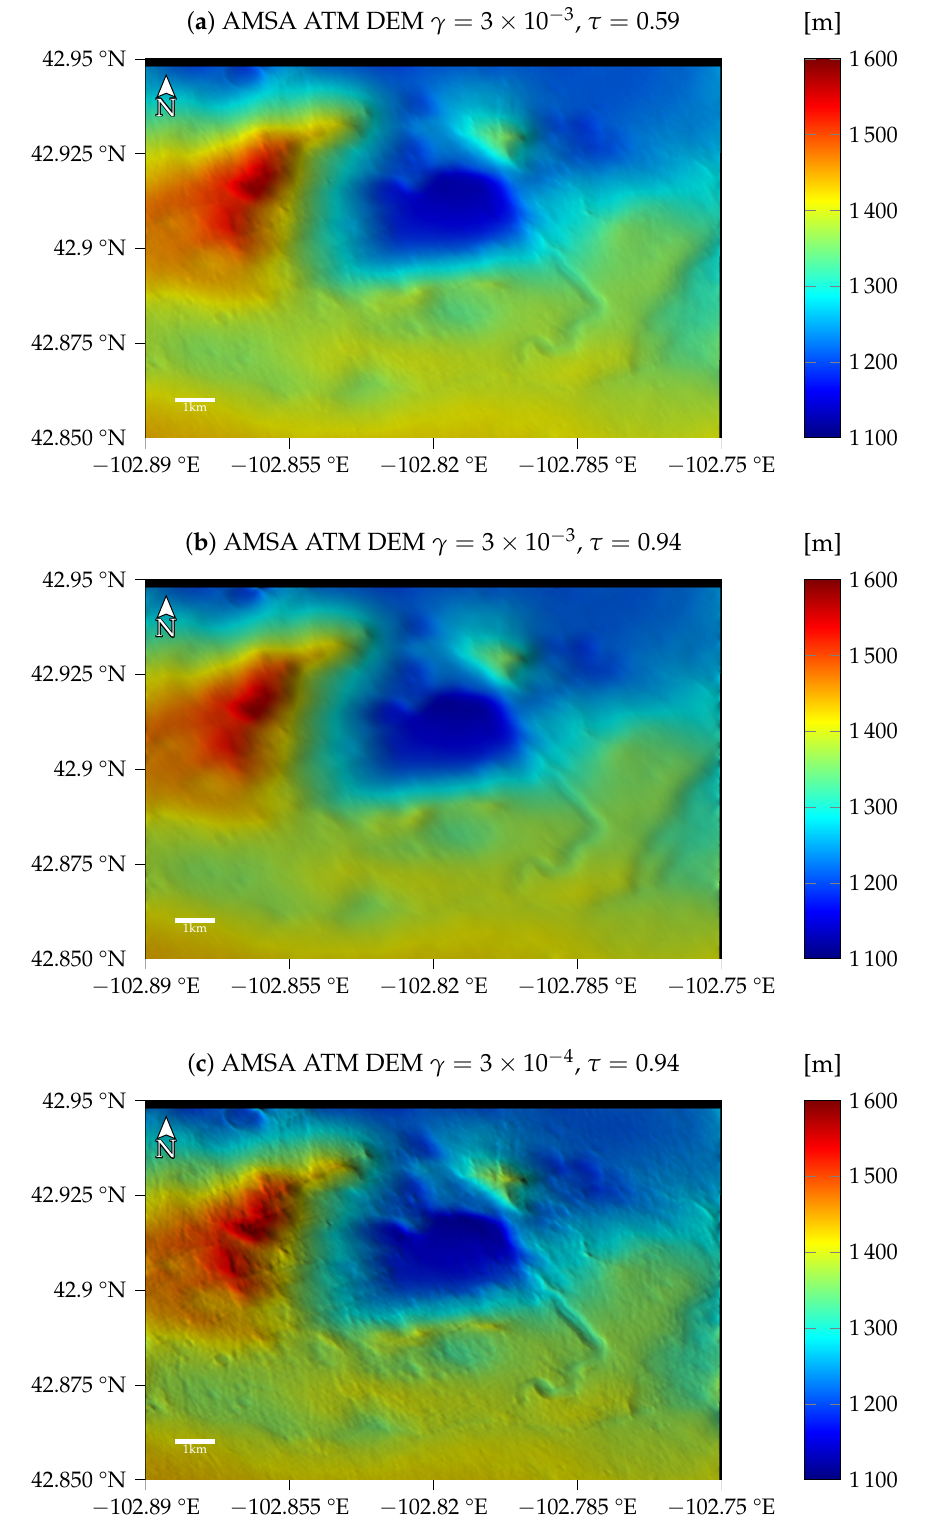
Figure A8. Color-coded and shaded DEMs created with the atmospherically compensated method not displayed in the main text of the manuscript for image K13_058475_2232_XN_43N103W (bad atmospheric